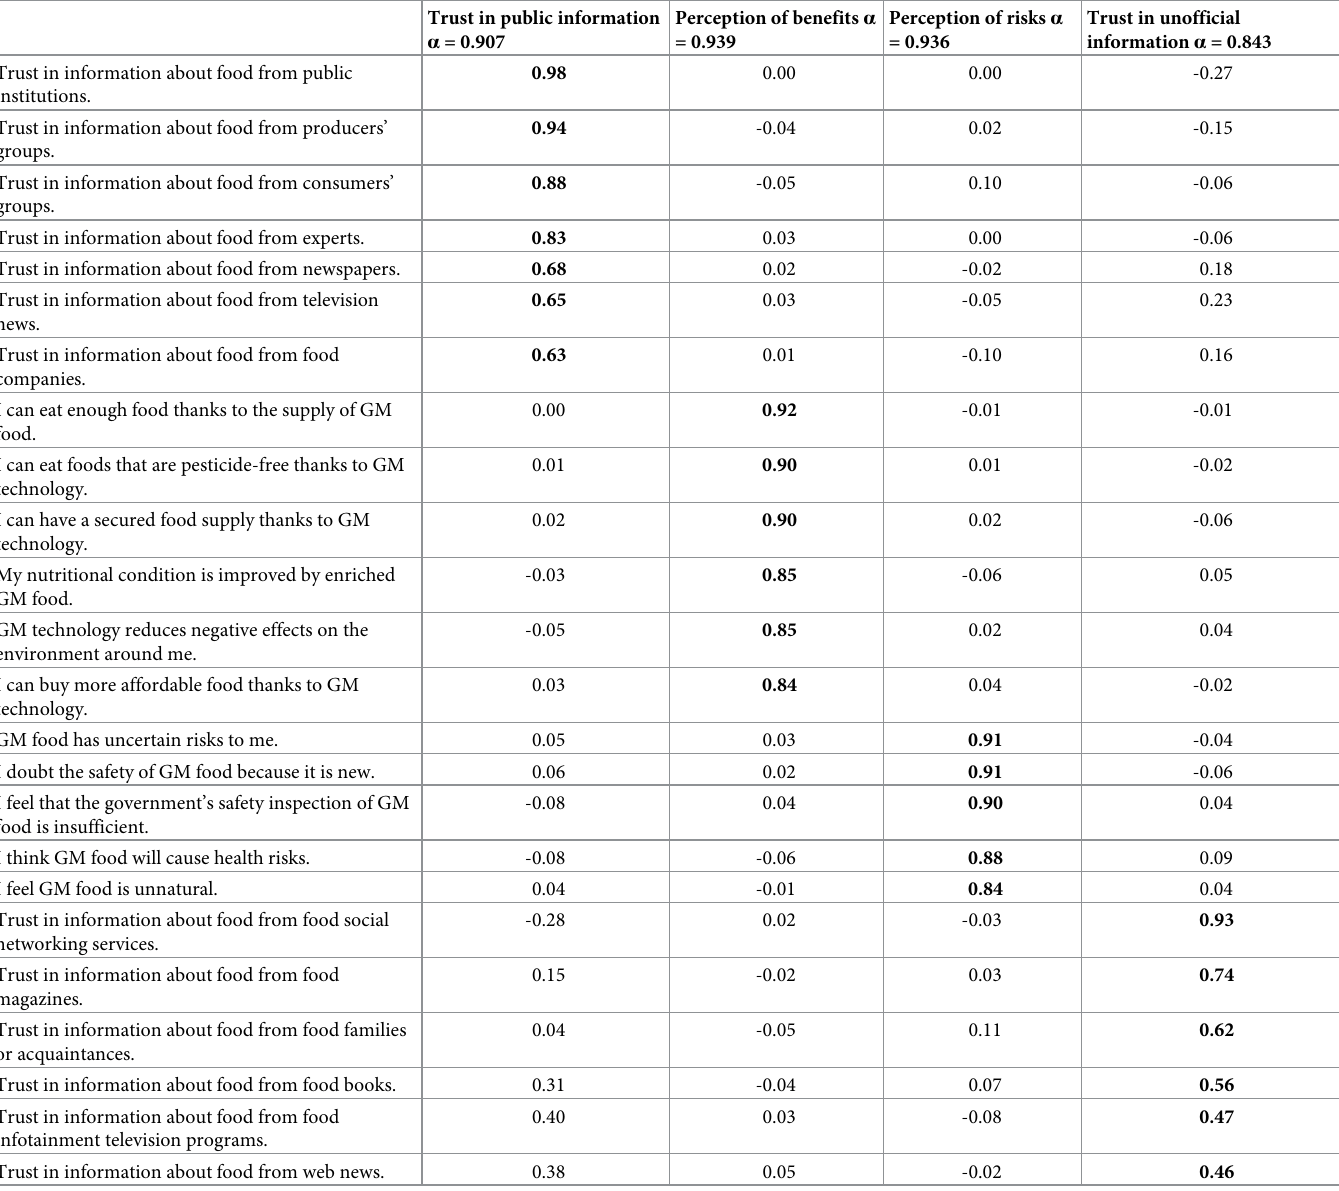
Table 2. Promax rotated component loadings for trust in information sources and perception of risks and benefits of GM